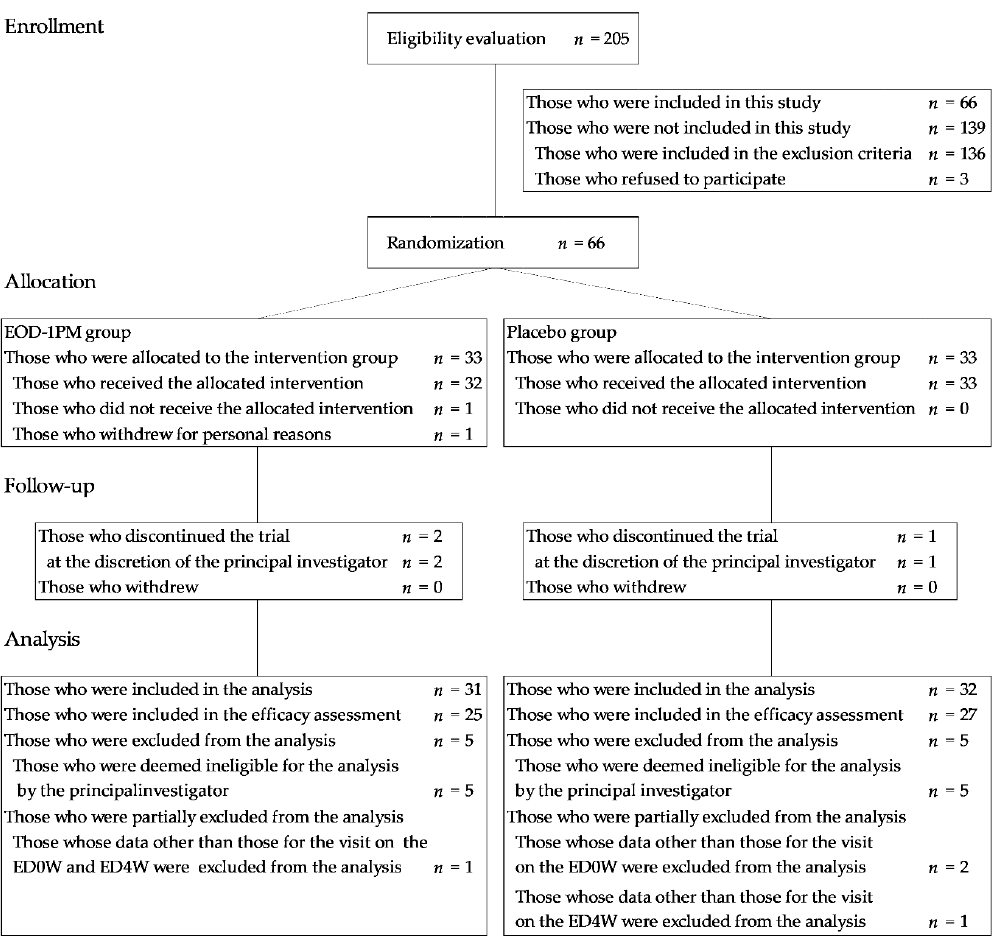
Figure 2. Flow diagram of participants. ED0W, examination day at 0 weeks; ED4W, examination day at 4 weeks after the start of the intake.